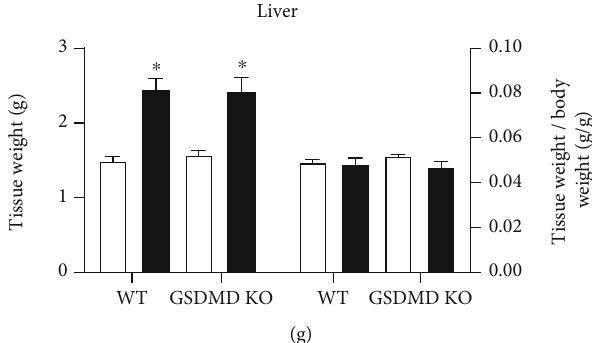
Figure 1: Body weight and food intake in wild-type (WT) and gasdermin D knockout (GSDMD KO) mice fed a high-fat diet (HFD). (a and b) Measurements of changes in body weight during a HFD or normal chow diet (NCD) in WT and GSDMD KO mice. (c and d) Measurements of food intake in WT and GSDMD KO mice fed a NCD or HFD. (e – g) Tissue weight and ratio of tissue weight per body weight in subcutaneous adipose tissue (SAT), visceral adipose tissue (VAT), and liver. ∗ p < 0 : 05 vs. same genotype mice fed a NCD and # p < 0 : 05 vs. WT HFD